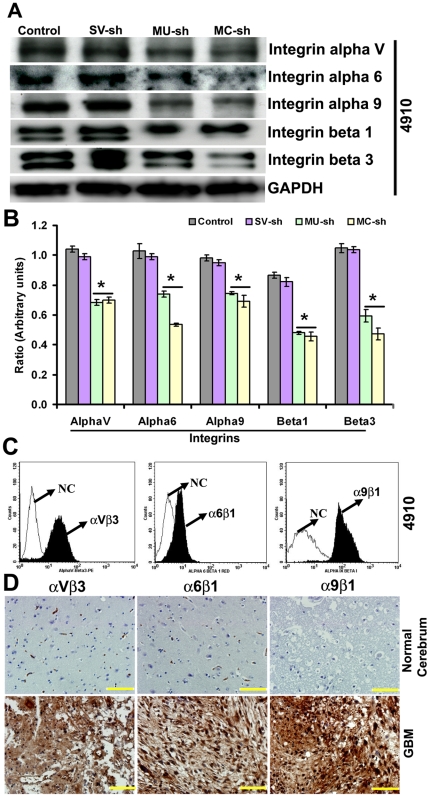
Effect of bicistronic constructs on integrins and the expression of αVβ3, α6β1 and α9β1 integrins on glioma xenografts and GBM clinical samples.(A) Western blot analysis depicting the reduced protein expressions of αV, α6, α9, β1 and β3 integrins after MMP-9/uPAR (MU-sh) and MMP-9/cathepsin B (MC-sh) plasmid shRNA treatments in 4910 cells. n = 3. Further, quantification of the Western blots (B) revealed significant reductions in protein expressions after MU-sh and MC-sh treatments. n = 3. Values shown are the mean (±SEM). *p<0.05 vs. control. (C) FACS analysis showing the presence of αVβ3, α6β1 and α9β1 integrin heterodimers on 4910 glioma xenogaft cells. 4910 cells, in which iso match mouse IgG used as the primary antibody served as negative controls. NC-negative control (D) Immunohistochemistry of normal cerebrum and glioblastoma multiforme (GBM) for αVβ3, α6β1 and α9β1 integrin heterodimer expressions. GBM tissue micro arrays were processed for immunohistochemistry. Prominent brown staining indicative of αVβ3, α6β1 or α9β1 integrin expression was noticed in GBM samples. Scale bar = 100 µm.